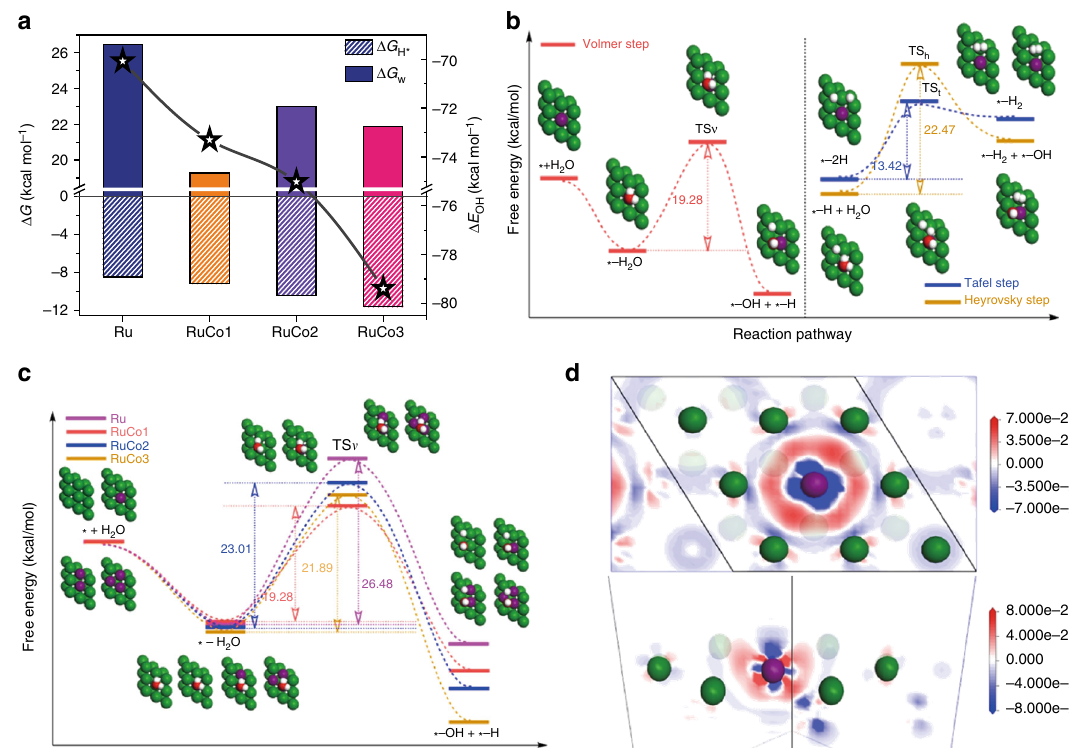
Fig. 5 DFT calculations to gain insights into the atomic Co substitution effect on the HER activity. a The hydrogen adsorption-free energy ( Δ G H *), water dissociation energy barrier ( Δ G w ) and OH binding energy ( Δ E OH ) on various metal surfaces with different amount of Co substitution. b Free energy diagrams of the three elementary processes of HER on RuCo1 including atomic con fi gurations of reactant initial states, intermediate state, fi nal states and additional transition states (TSv, TSh and TSt represent the transition states of Volmer, Heyrovsky and Tafel step, respectively). c Free energy diagrams of the Volmer steps of HER on various metal surfaces with different amounts of Co substitution including atomic con fi gurations of reactant initial states, intermediate state, fi nal states and additional transition states (TSv). d Top view (up) and side view (down) of the electron density change plots after single Co atom substitution. Color: green, Ru; purple, Co; red, O; white,